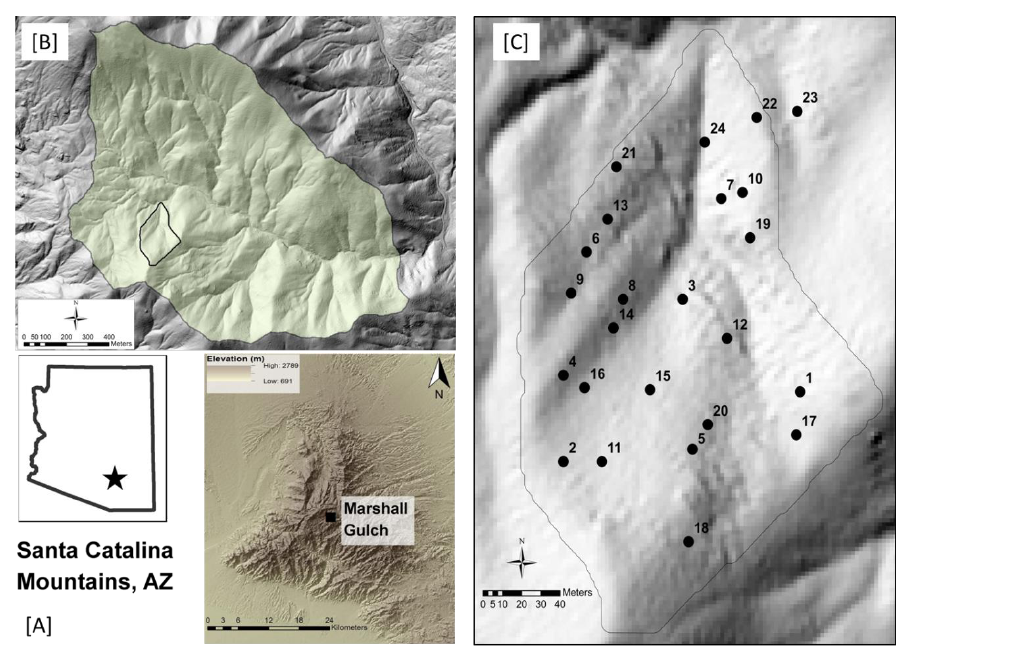
Figure 1. Location of study catchment in the (a) Santa Catalina Mountains in southern Arizona, USA, the (b) Marshall Gulch watershed, and (c) sample locations in the study catchment located in Marshall Gulch.